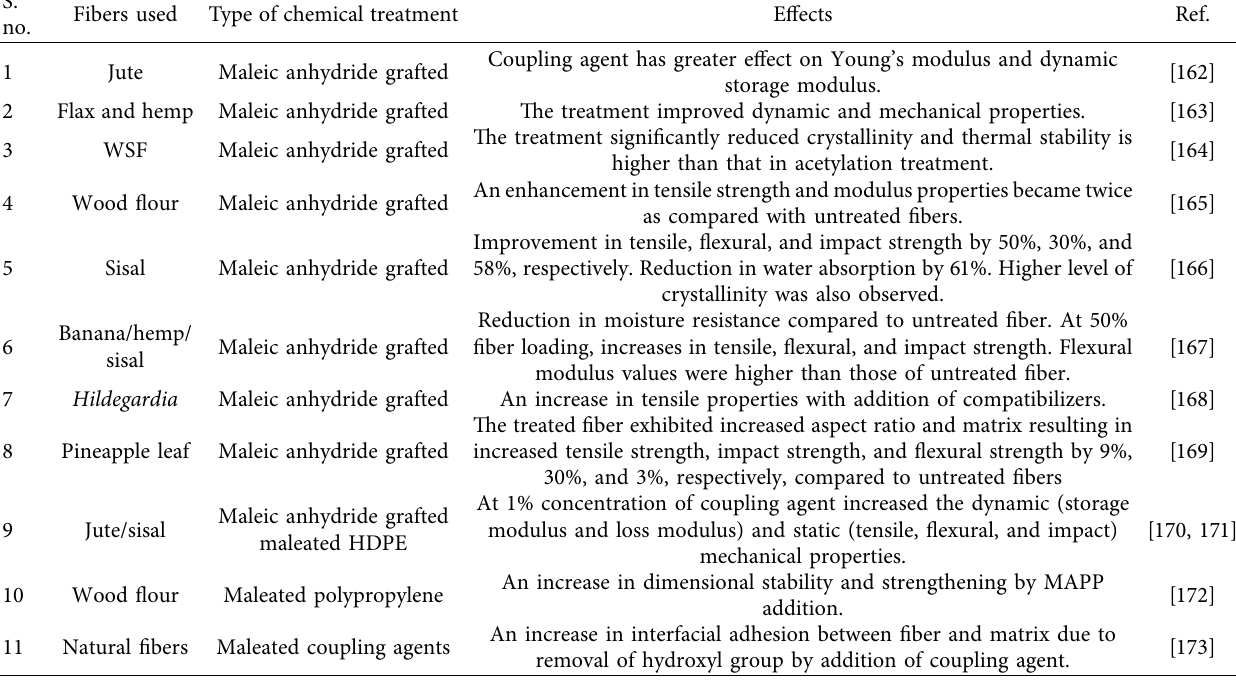
Table 10: Effect of maleic anhydride grafted treatment on various